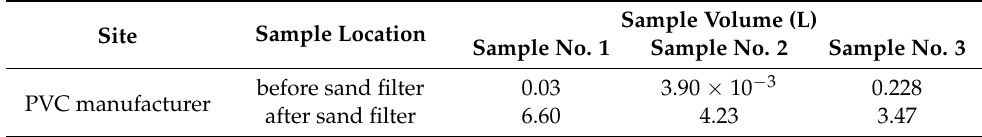
Table 3. Analyzed sample volumes of industrial samples extrapolated from the aliquots.